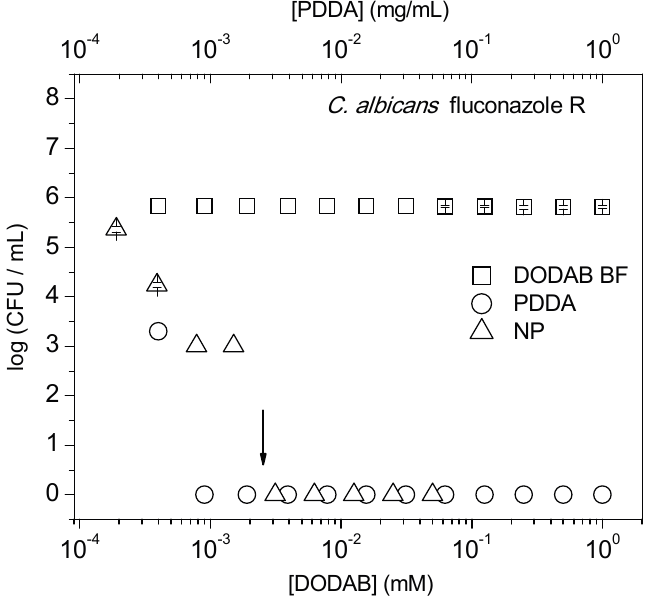
Figure 2. The cell viability of fluconazole-resistant C. albicans at 6–8 × 10 5 CFU/mL as a function of DODAB or PDDA concentrations. Interactions took place for 1 h. The MMC for PDDA in the NPs is indicated by the